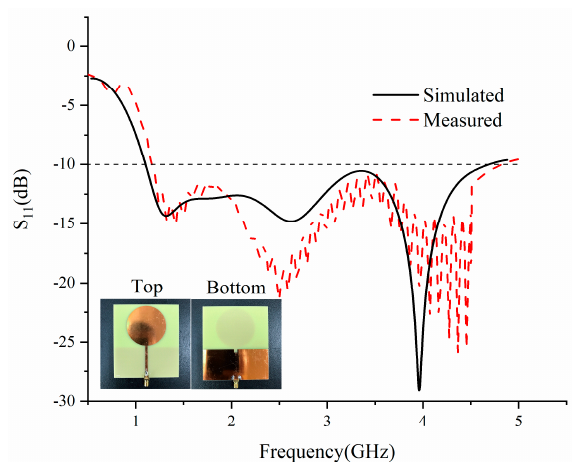
Figure 2. Simulated and measured input port voltage reflection coefficient (S 11 ) of the original UWB antenna.